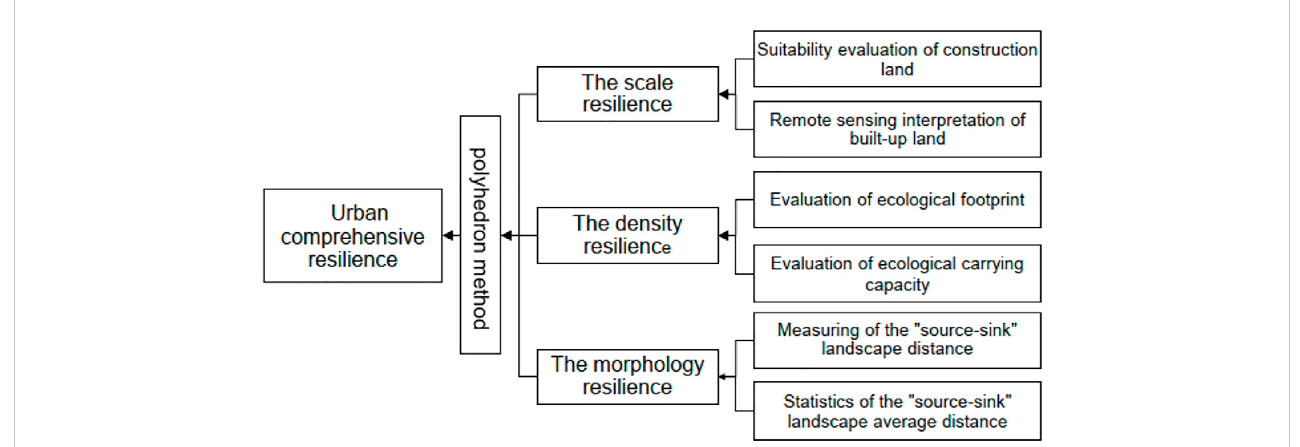
FIGURE 1 Scale-density-morphology urban resilience evaluation framework.